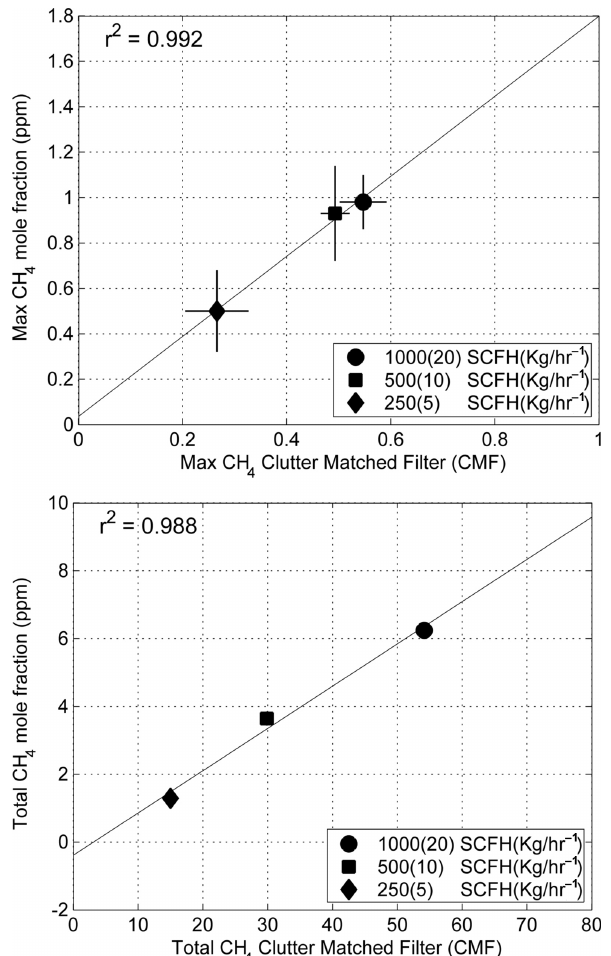
Figure 11. Scatter plots of maximum and total CH 4 concentration (ppm) and CMF values (unitless) for three different flux rates (250, 500, 1000 standard cubic feet per hour) at the controlled release site near Bakersfield, CA, on 28 April 2015. The max values (top panel) represent the highest concentration/CMF values in the vicin- ity of the release point above background values, while the total value (bottom panel) represents the accumulated sum of quantita- tive/CMF values over the detected plume pixels determined from thresholding the CMF result. The quantitative retrieval and CMF results have high correlation (0.992 and 0.988), which gives confi- dence in using the more efficient CMF method to rapidly detect and attribute methane plume point sources when compared to the more rigorous and slower retrieval approach (<0.1spixel − 1 for the CMF as opposed to 12spixel − 1 on average for the